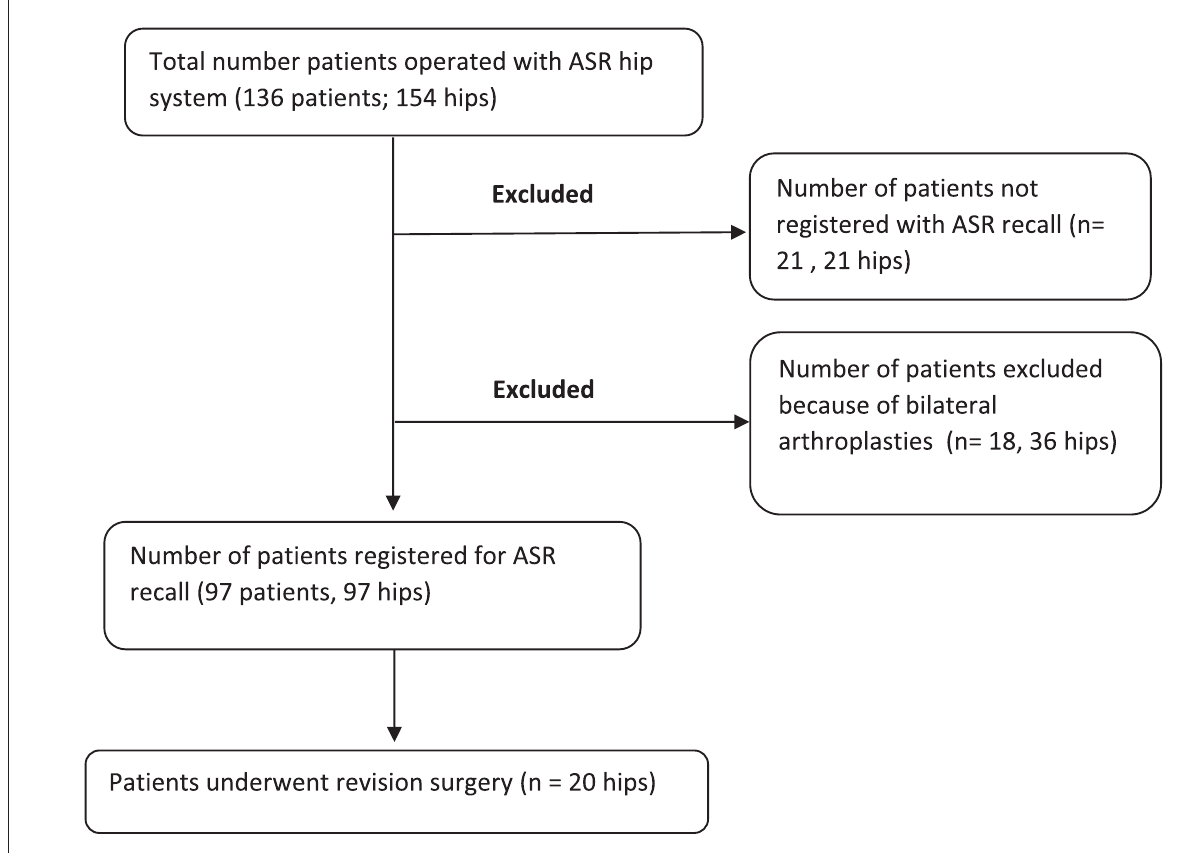
Figure 1. Consort Flow Diagram of the patients enrolled in this study who underwent THR using ASR system.